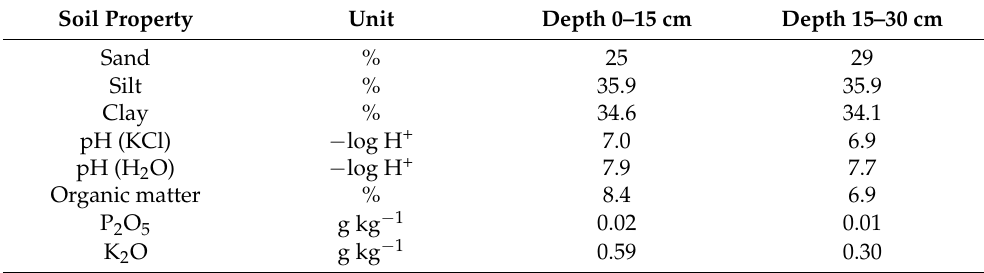
Figure 1. Study area in coastal region of Croatia with fire-affected abandoned olive orchard and three fire severity treatments established: high severity, moderate severity, and unburned control. Table 1. General soil properties of investigated